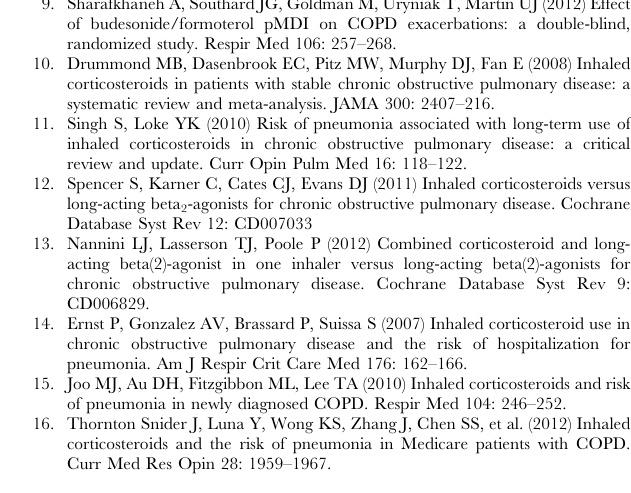
Table S7 Summary of studies investigating the association between pneumonia and use or non-use of ICS. ACE: angioten- sin-converting-enzyme; CAP: community-acquired